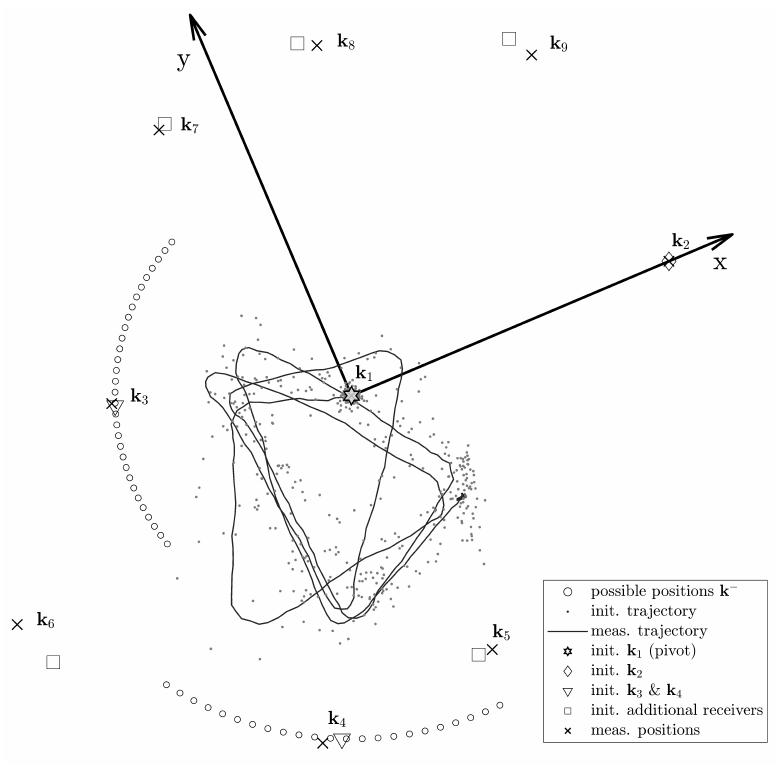
Figure 10. Initialization with direction adjudgement